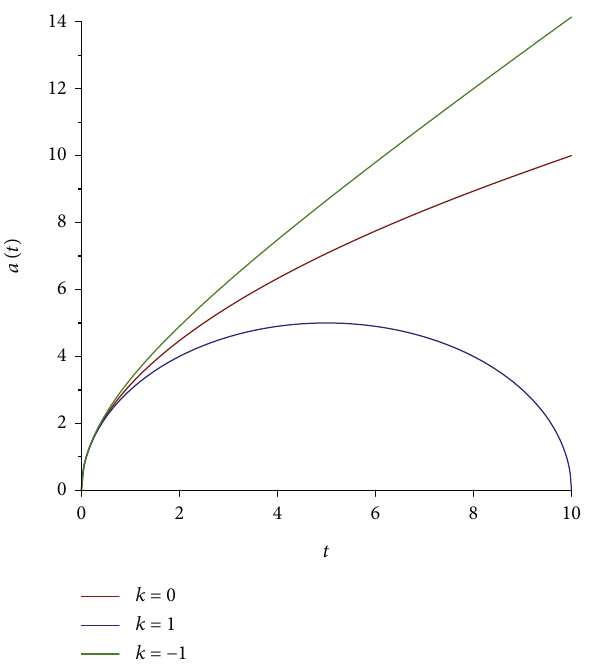
Figure 1: Plot of a ð t Þ versus t for di ff erent values of k . Figure 2: Plot of Λ ð t Þ versus t for di ff erent values of k